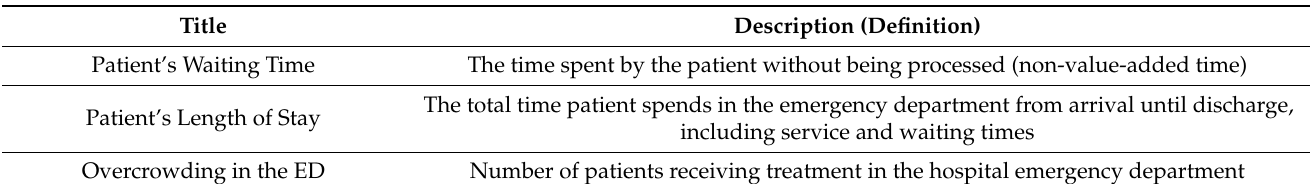
Table 3. Critical to satisfaction characteristics.